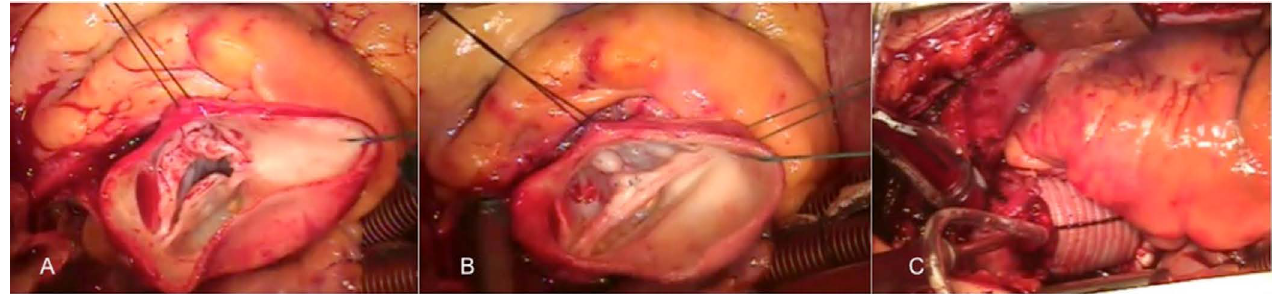
Fig. 1 - A- bicuspid aortic valve type 1 with the raphe between the left and right coronary cusp. Fibrotic thickening of the free margins and the median raphe can be seen. Severe prolapse of the fused cusp. Aorta above the STJ with important aneurysm. B - Surgical correction included the circumferential circular external reduction of the aortic annulus ring with Teflon strip, shaving of the fibrotic portions of the fused cusp and prolapse correction. At the end, both cusps are at the same level and with appropriate effective heights. C - Final aspect of the operation. The ascending aorta was replaced by Dacron